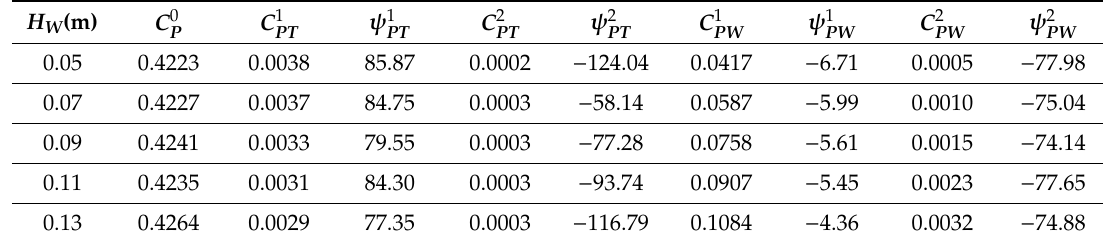
Table 7. Expansion coe ffi cient table of energy utilization ratio under the di ff erent wave heights.